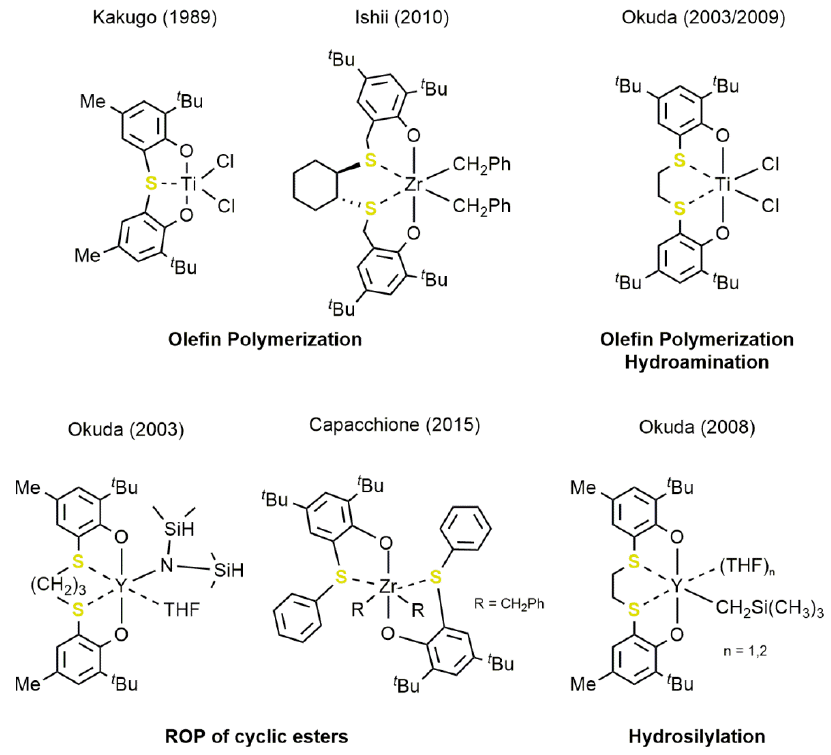
Figure 4. Representative examples of complexes bearing [OSO], [OSSO], or [OS]-ligands